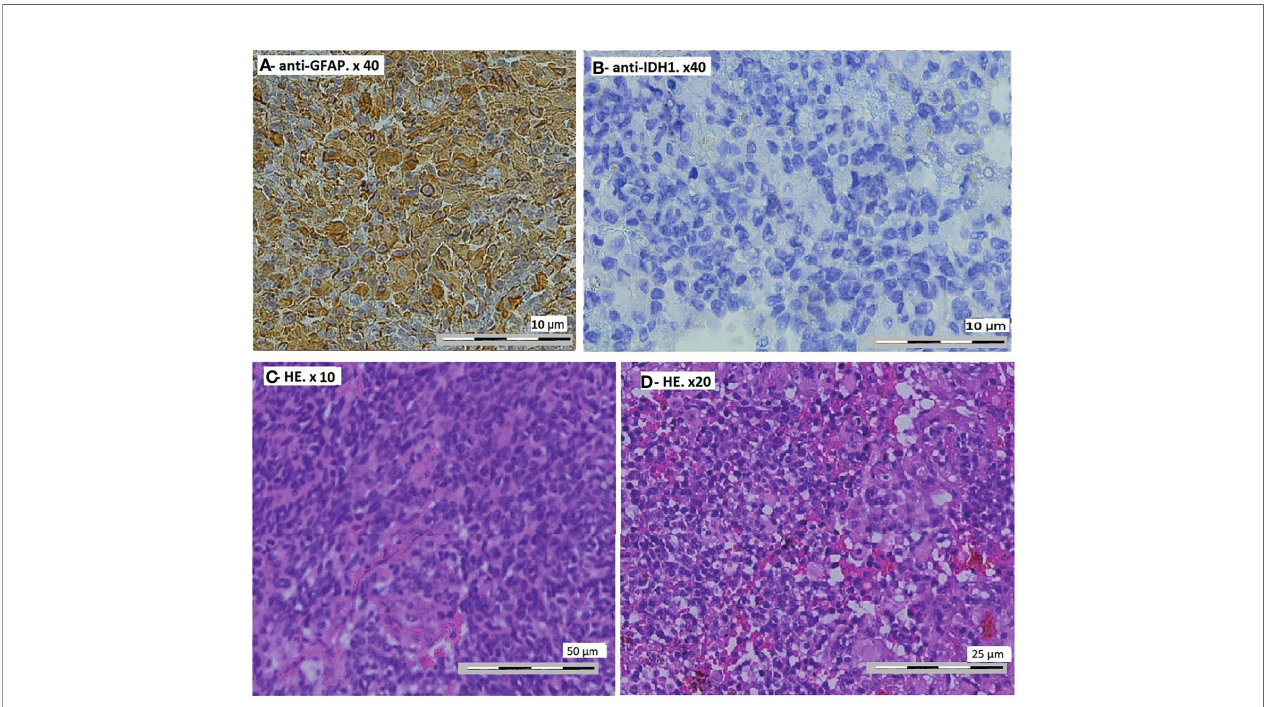
FIGURE 2 | Pathological fi ndings on the tumor. (A) Focal positivity of the tumor cells to anti-GFAP (glial fi brillary acidic protein). Immunohistochemistry, anti-GFAP, ×40 magni fi cation. (B) Negativity of tumor cells to anti-IDH1. Anti-IDH1 immunohistochemistry (R132H), ×40 magni fi cation. (C) Global value of the proliferation. Hematoxylin – eosin stain, ×10 magni fi cation. (D) Diffuse tumor proliferation, poor differentiation, and rich vascularization. Hematoxylin – eosin stain, ×20 magni fi